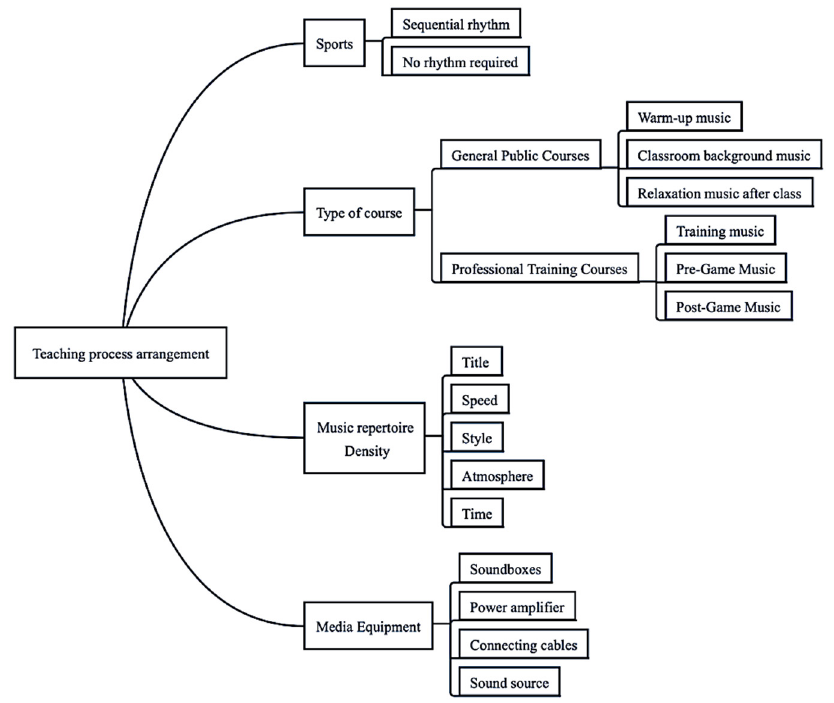
Figure 5. Figure of the PE teaching process under musical conditions.